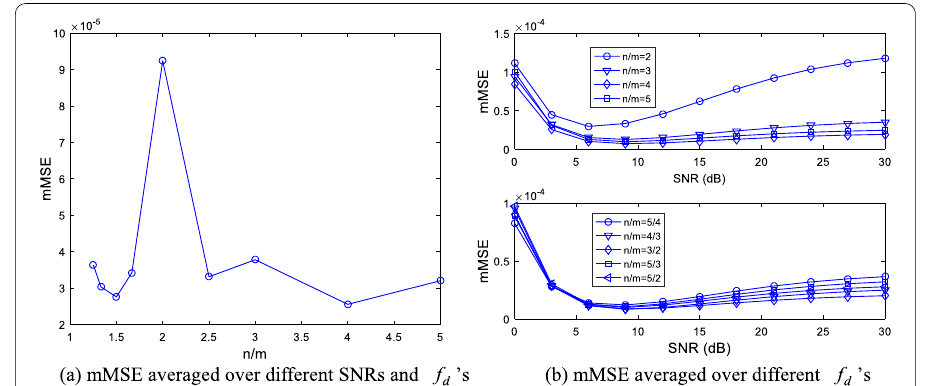
Fig. 5 The mismatched MSE (mMSE) for Doppler shift